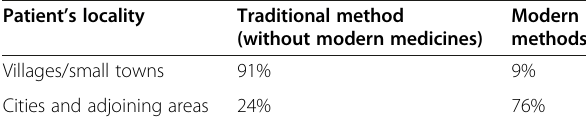
Table 5 Methods applied for treatment of